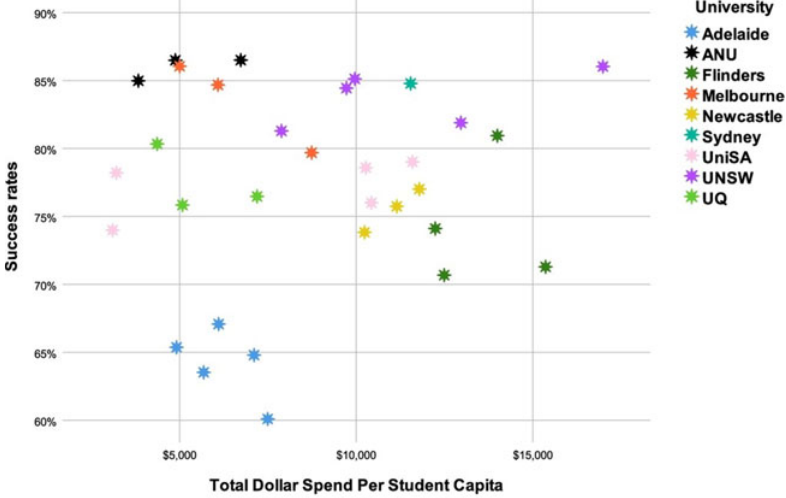
Fig. 3. Success rate v total spend per capita 2009 – 2015 (8 univer- sities, 32 data